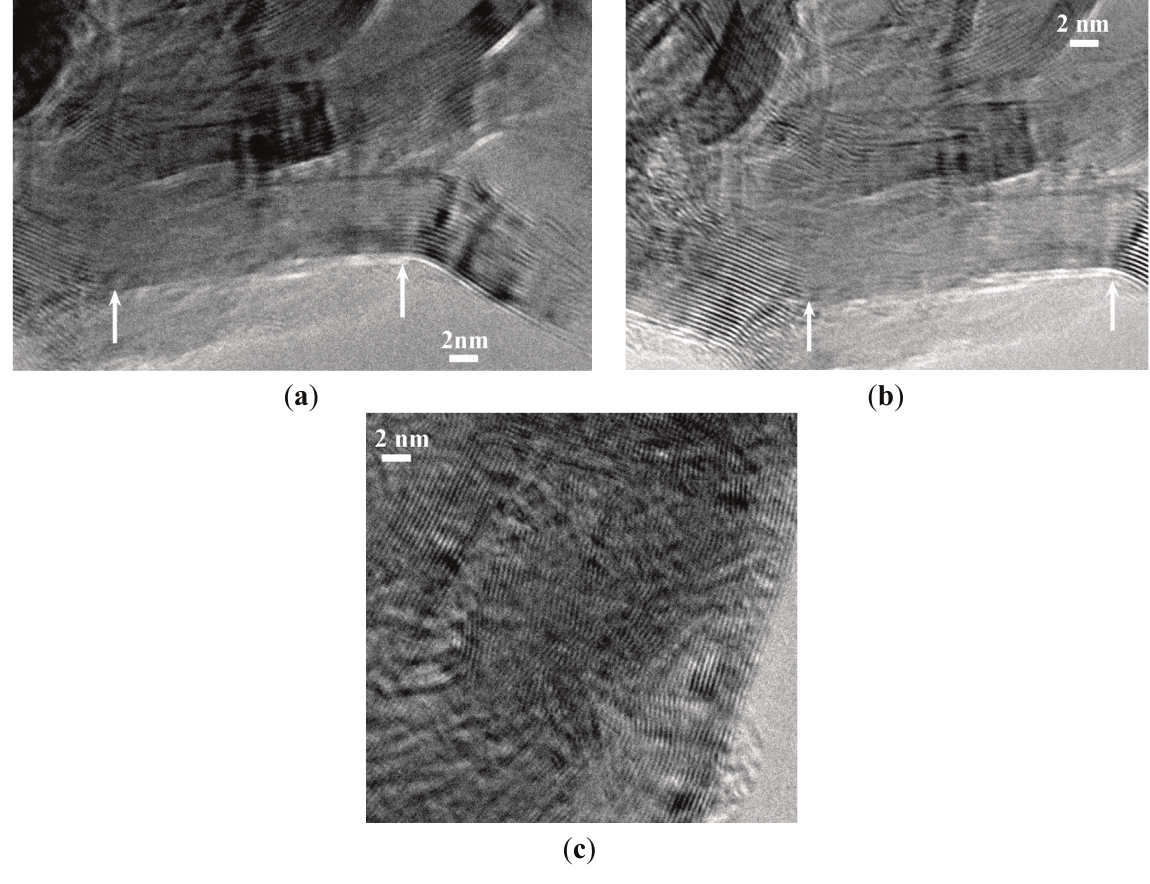
N -NP2000BM evidencing in ( a ) and ( b ), a 1.0 0.9